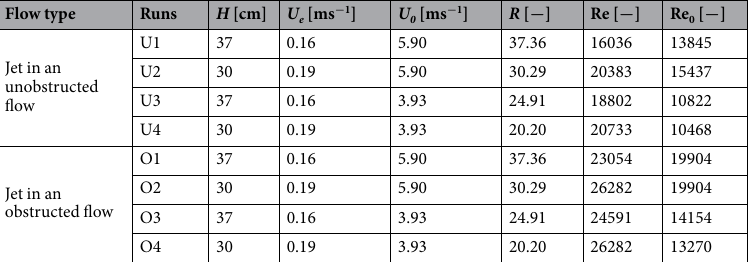
Table 1. Main parameters of the experimental